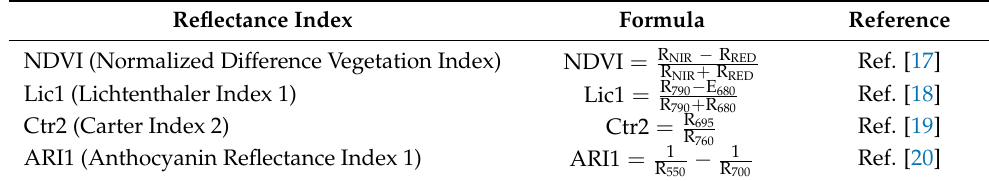
Table 2. Reflectance indices calculated by the PolyPen RP410 based on hyperspectral data. Reflectance Index Formula Reference NDVI (Normalized Difference Vegetation